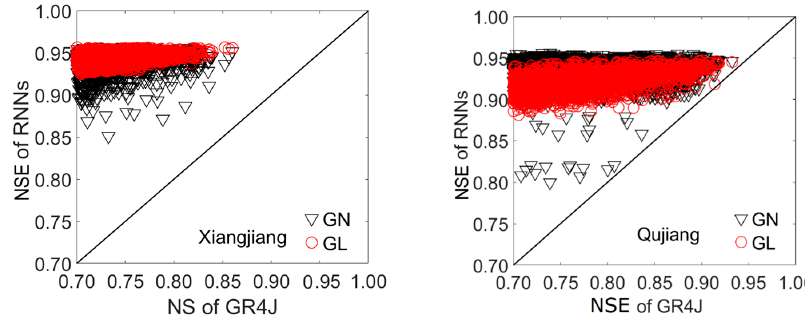
Figure 5. NSE values for GR4J, GN, and GL in the Xiangjiang and Qujiang basins.